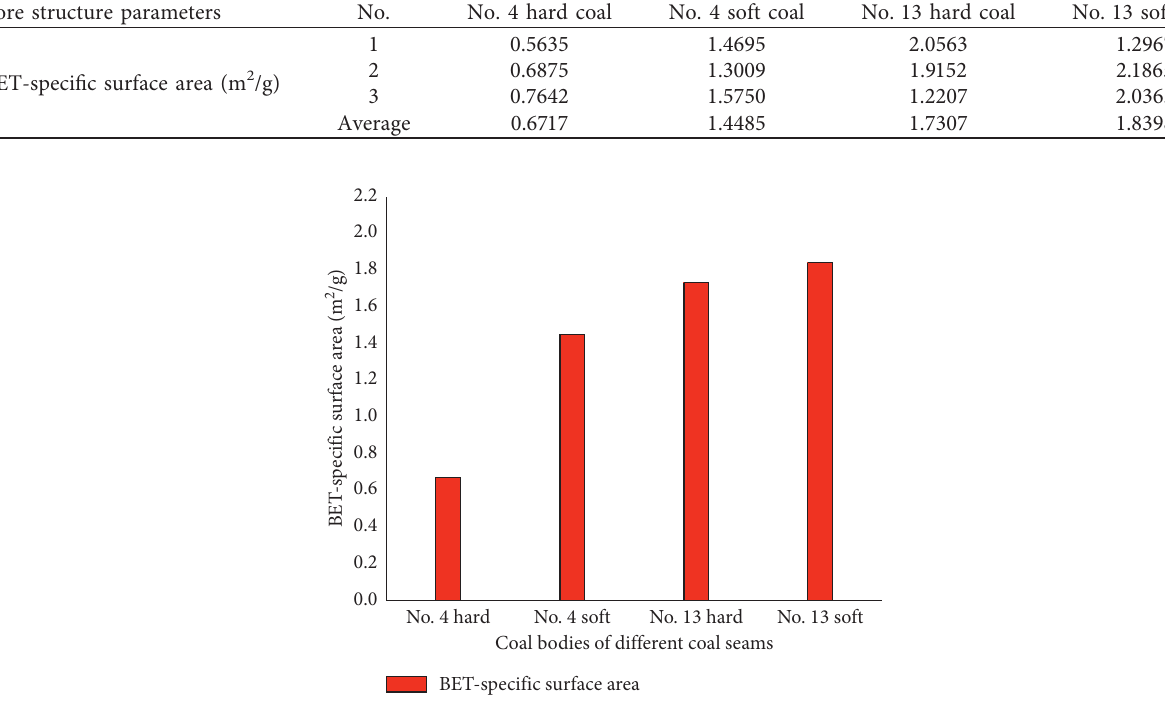
Figure 6: BET-specific surface areas of the different coal seams. Table 4: BJH-specific surface areas of the different coal